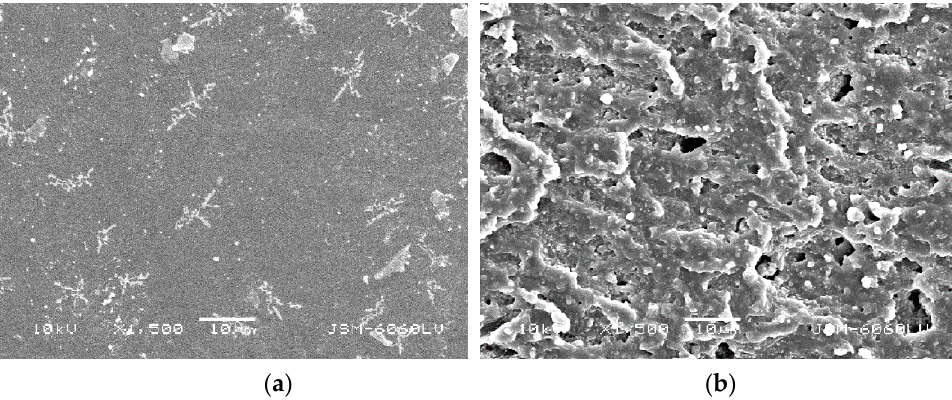
Figure 11. SEM images of printing plate samples before the exposure to solvents: ( a ) Photopolymer with 10× UV treatment, ( b ) EPDM with 0× UV treatment.